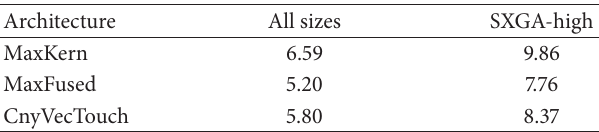
Table 6: Kernel-Ratios (geometric mean of all kernel speedups) relative to CPU1 for the SXGA image with high disparity and for the geometric mean over all sizes.